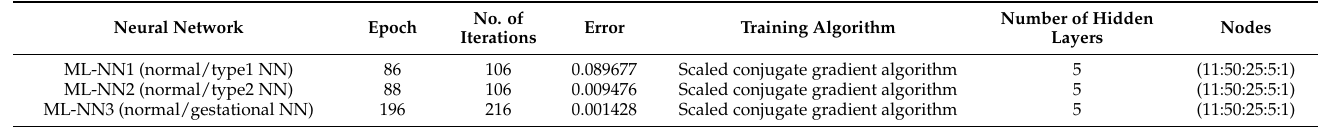
Table 1. Multi-layer neural network parameters.